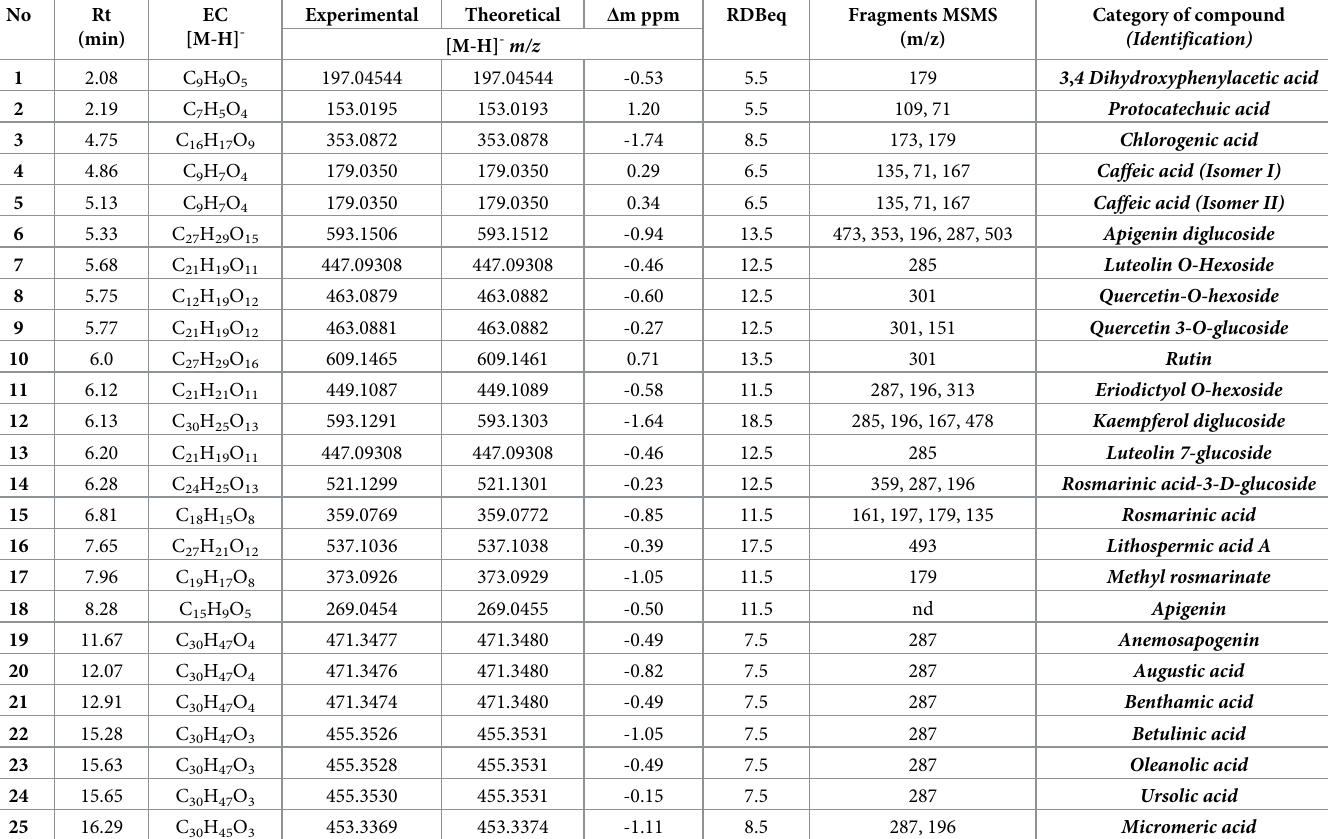
Table 4. LC(ESI-)HRMS of T . longicaulis methanol